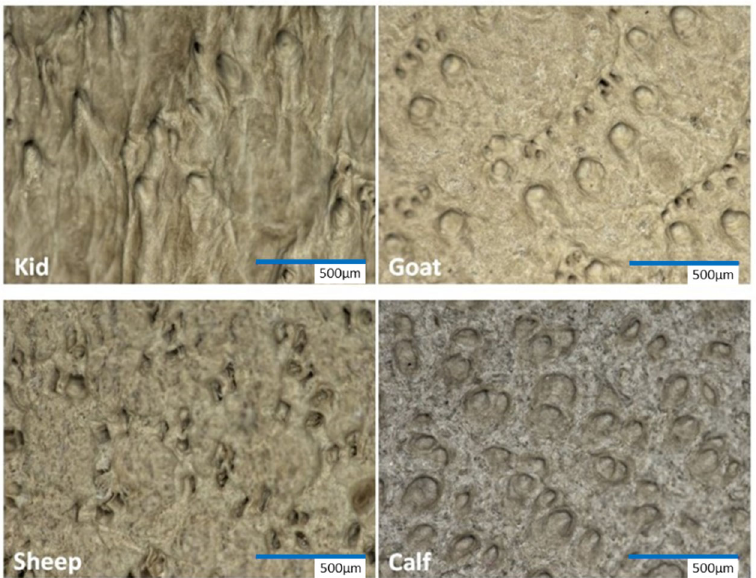
Figure 1. Comparison of parchment follicle patterns from kid, goat, sheep and calf at 200× magnification. ©https://blogs.bl.uk/collectioncare/2013/09/index.html. ( Accessed on 19. July.2022)